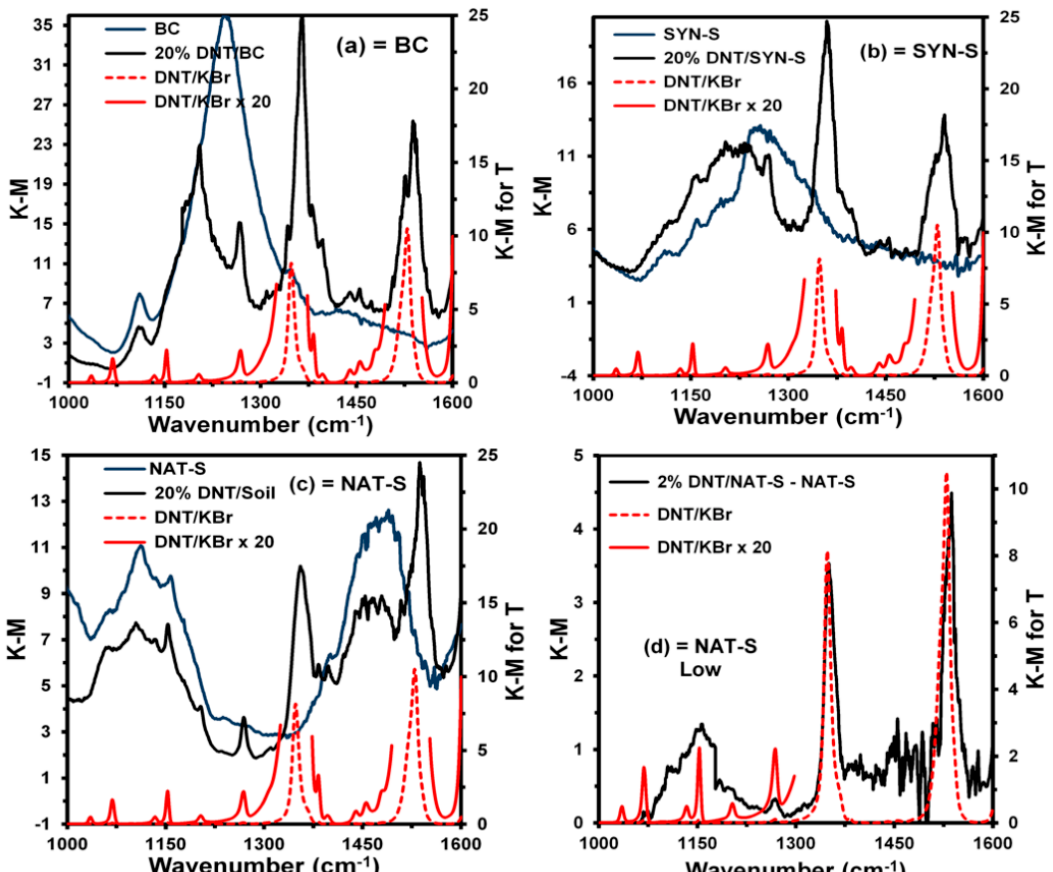
Figure 3. DNT spectrum in the investigated soil matrices in K-M (K-M for T: K-M calculate from transmittance for red spectra): ( a ) BC; ( b ) SYN-S; ( c ) NAT-S, and ( d ) NAT-S Low.